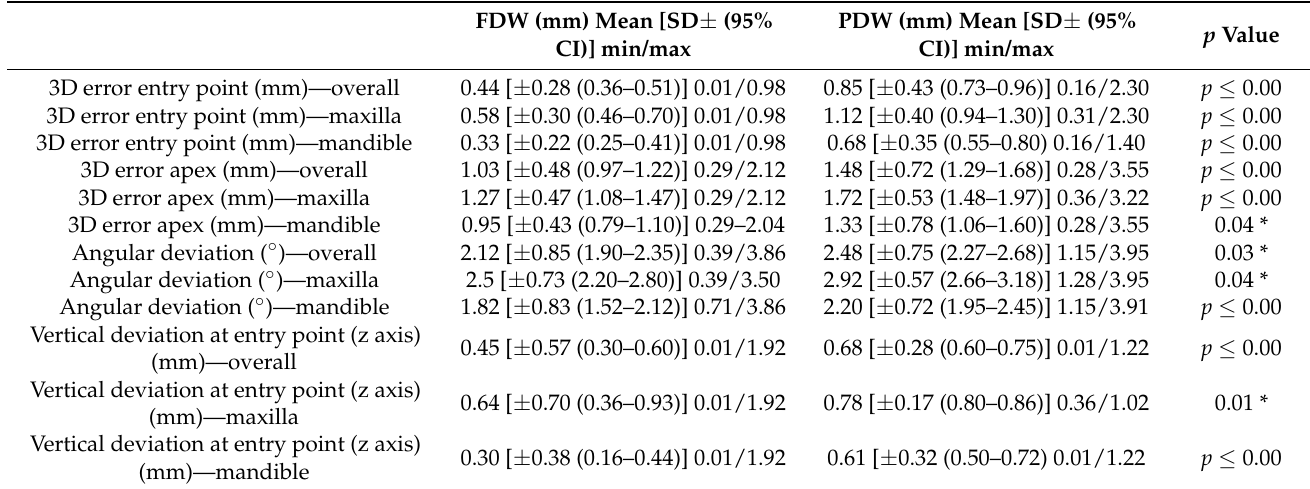
Table 4. Assessment of trueness for FDW and PDW.